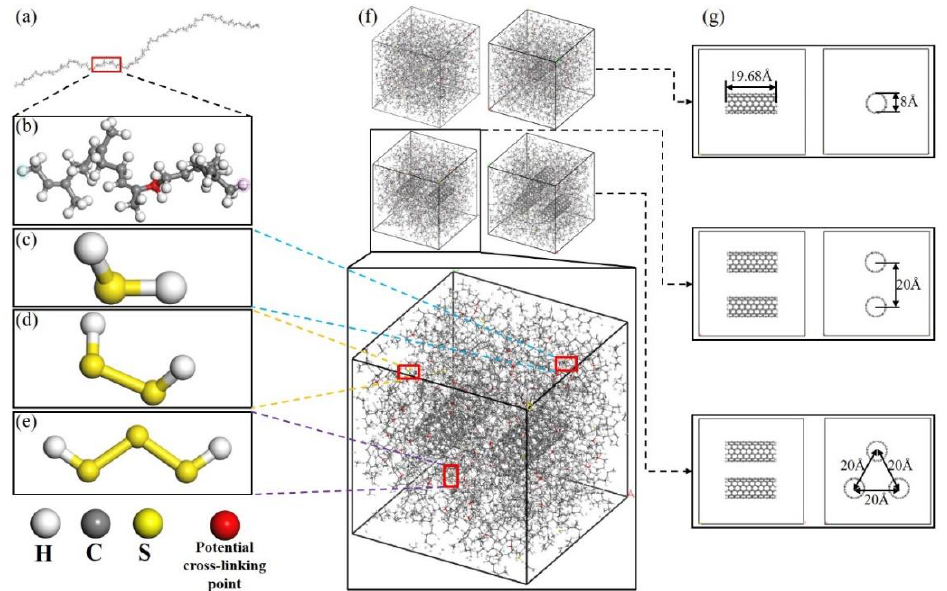
Figure 2. Establishment of un-crosslinked CNT/VNR molecular models. ( a ) NR molecular chain. ( b ) Five repeating units with one potential cross-linking point. ( c ) Monosulfide. ( d ) Disulfide. ( e ) Polysulfide. ( f ) Different CNT contents un-crosslinked CNT/VNR molecular models. ( g ) Size and corresponding positions of the nanotubes.